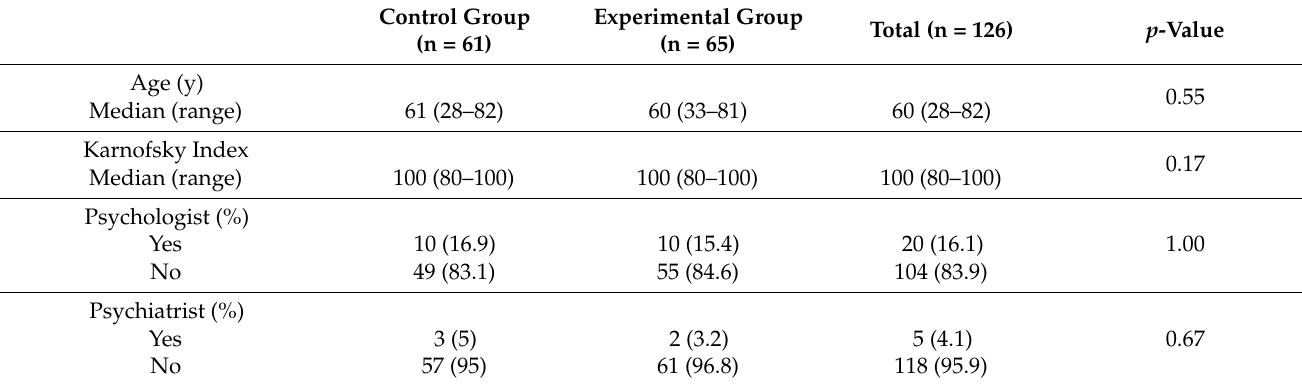
Table 1. Patient